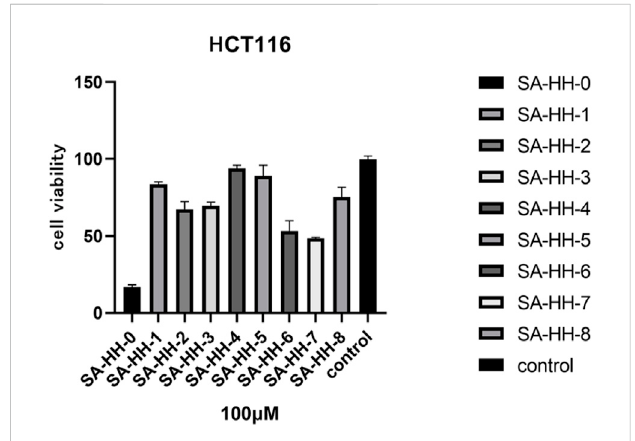
FIGURE 8 Effects of 100 μ M Samoamide A derivatives on cell